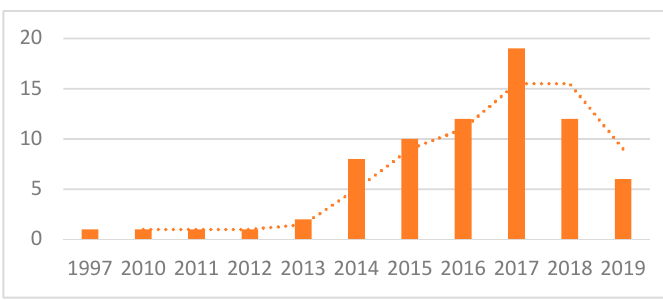
Figure 1. Publishing years of articles included in the review.